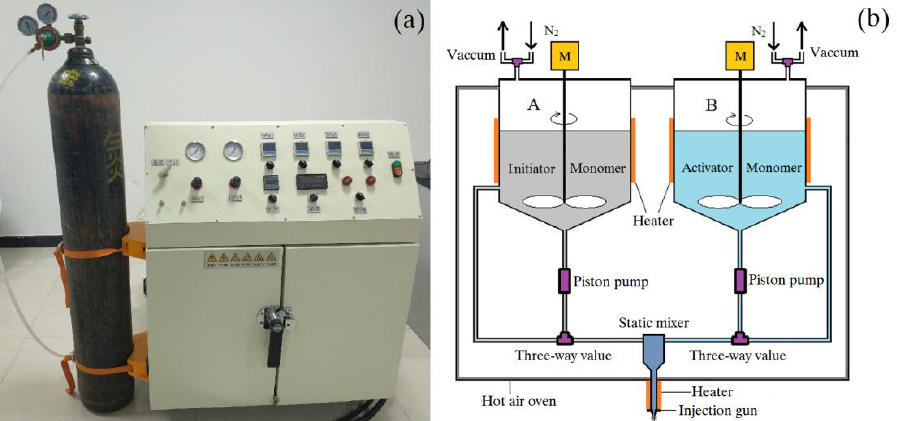
Figure 5. The specially designed resin injection molding (RIM) device: ( a ) overview of RIM device, and ( b ) schematic diagram of the device.